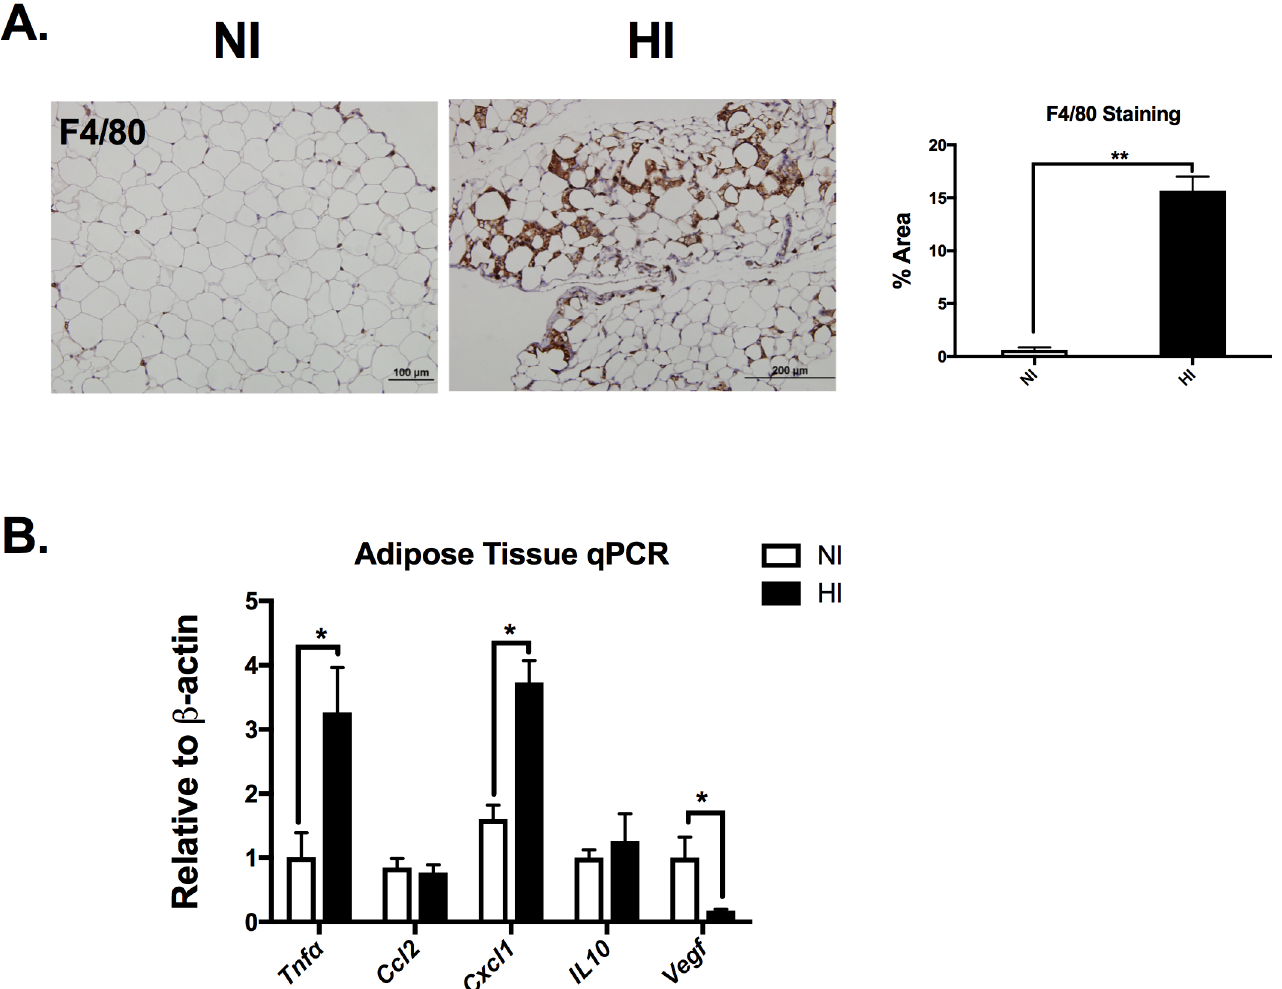
Fig 5. Iron deposition is associated with increased adipose tissue inflammation. A) Representative adiposetissue F4/80 inmmunoflorescent staining from both NI (left) and HI (right) groups. Quantification for F4/80 antibody stainingrevealedmacrophage clusteringamong the adipocytesin HI group. B) eAT geneexpressionwith inflammatory gene markers. Abbreviations : Tnf α , tumor necrosis factor; Ccl2 , C-C Motif Chemokine Ligand 2; Cxcl1 , C-X-C Motif ChemokineLigand1, Il10 , interlukin10; Vegf α ,Vascular endothelial growth factor A. * p <